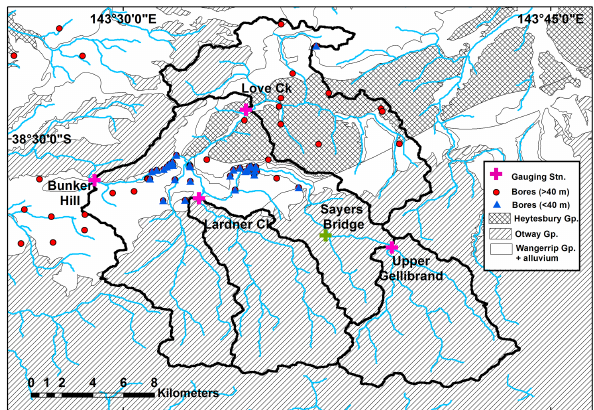
Figure 1. Location and geology of the Gellibrand River catchment in Victoria, Australia, showing catchment and gauged subcatch- ment boundaries, monitoring bores, gauging stations and the Sayers Bridge (ungauged) river sampling